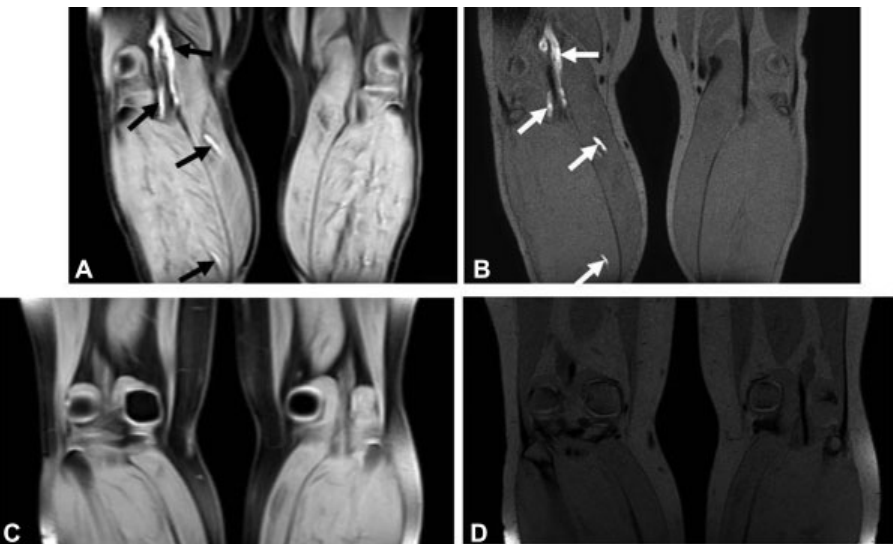
Fig. 1 A 51-year-old male patient ( patient 1 , ► Table 2 ) with a recurrent DVTof the left leg, shown on the MRDTI sequence ( A ) ( black arrows ) and TSE-SPAIR sequence ( B ) ( white arrows ). A 42-year-old female patient with a suspected recurrent DVTof the right leg ( patient 11 , ► Table 2 ), ruled out based on the results of the MRDTI ( C ) and TSE-SPAIR ( D )